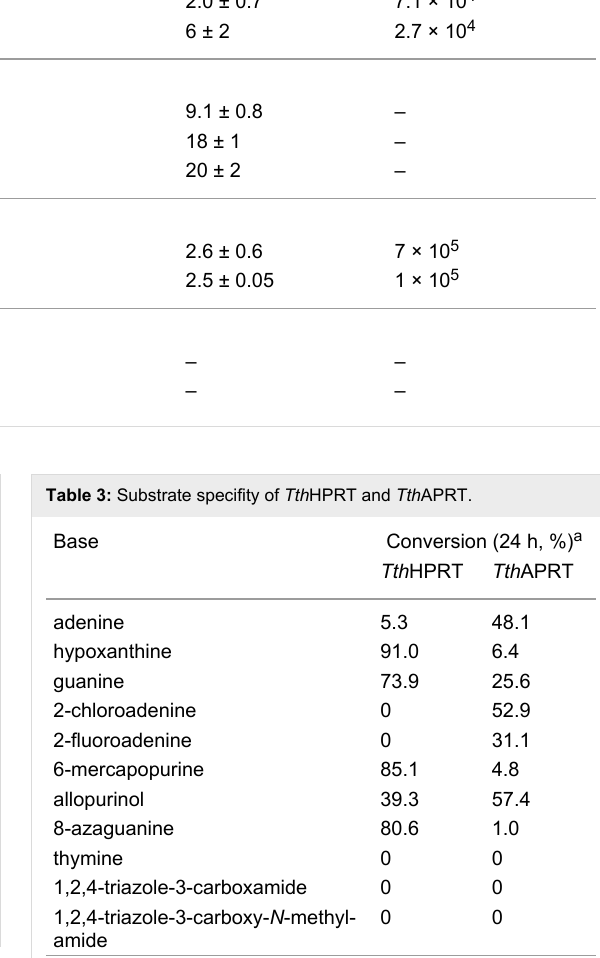
and orotate phosphoribosyltransferase only [2]. Unfortunately,